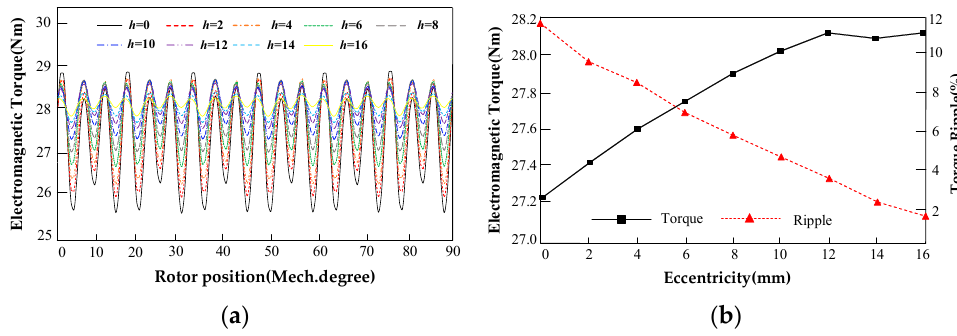
Figure 13. ( a ) Permanent magnet torque under different eccentricity; ( b ) The average value of permanent magnet torque and torque ripple under different eccentricity.